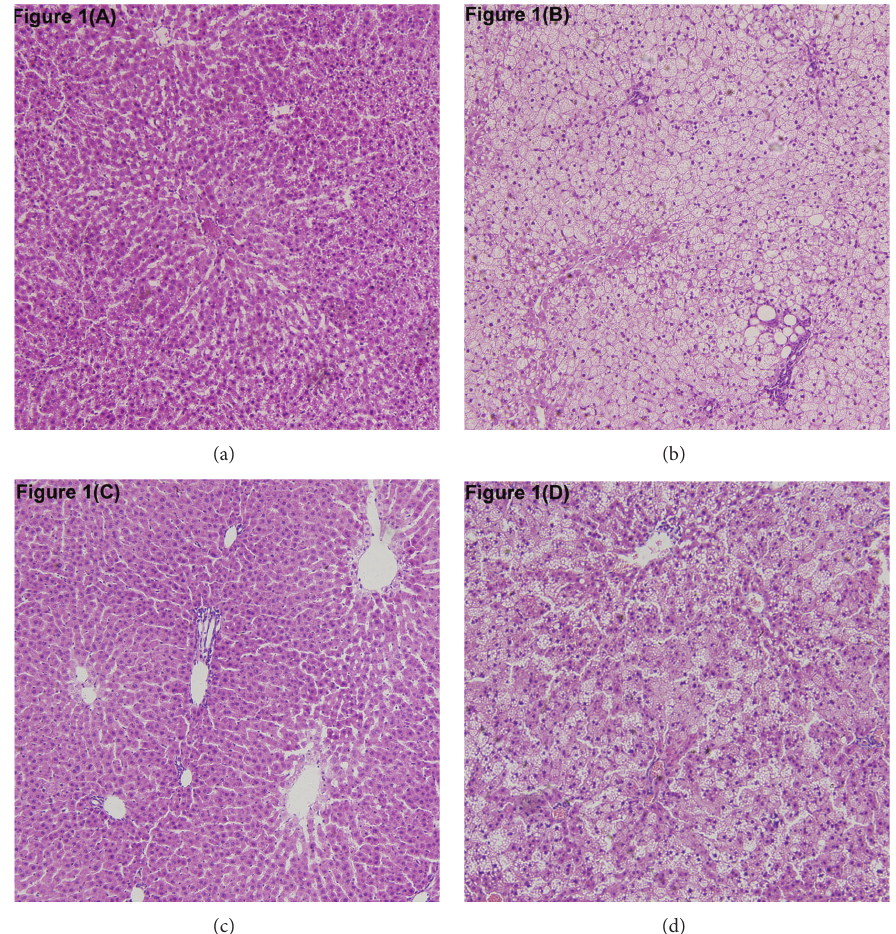
Figure 1: Effects of pioglitazone on hepatic steatosis in rats fed a high-fat diet. Hepatic histopathological changes in the normal control (a) and pioglitazone control (c) groups were within normal limits. Severe hepatic steatosis was found in the high-fat diet group (b). Hepatic steatosis was significantly improved in the high-fat diet plus pioglitazone group (d). (Haematoxylin and eosin; original magnification × 10.)